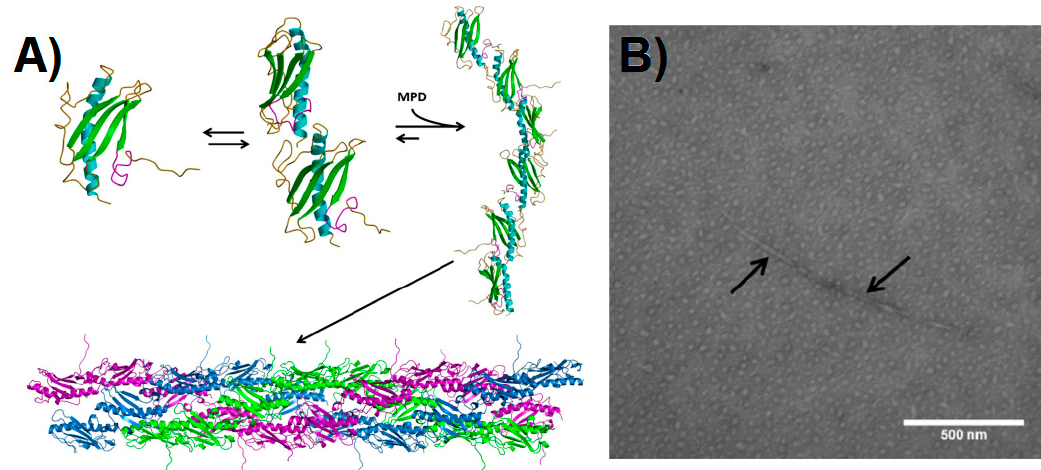
Figure 2. Pilin-derived protein nanotube (PNT) assembly. ( A ) The ∆ K122 pilin (PBD ID 1QVE [45]) exists as a monomer-dimer equilibrium in solution [55]. The common structural features of the type IV pilins are highlighted in the monomer—the N-terminal α -helix in cyan, the β -sheet in green, coil regions in gold, and the receptor-binding domain (known to mediate surface interactions) in magenta. Upon addition of a hydrophobic compound such as 2-methyl-2,4-pentanediol (MPD), the ∆ K122 pilin forms fibrils that can then assemble into PNTs. The three ∆ K122 fibrils observed in a helical assembly of native T4P are shown in purple, green, and blue, respectively. ( B ) Upon the addition of the oligomerization initiator MPD, the ∆ K122 monomer / dimers are seen as aggregates in TEM, and form pilin fibrils (highlighted by arrows). (Reprinted with permission from Petrov et al. J. Nanobiotechnol . 11 , 24 (2013) [54]).